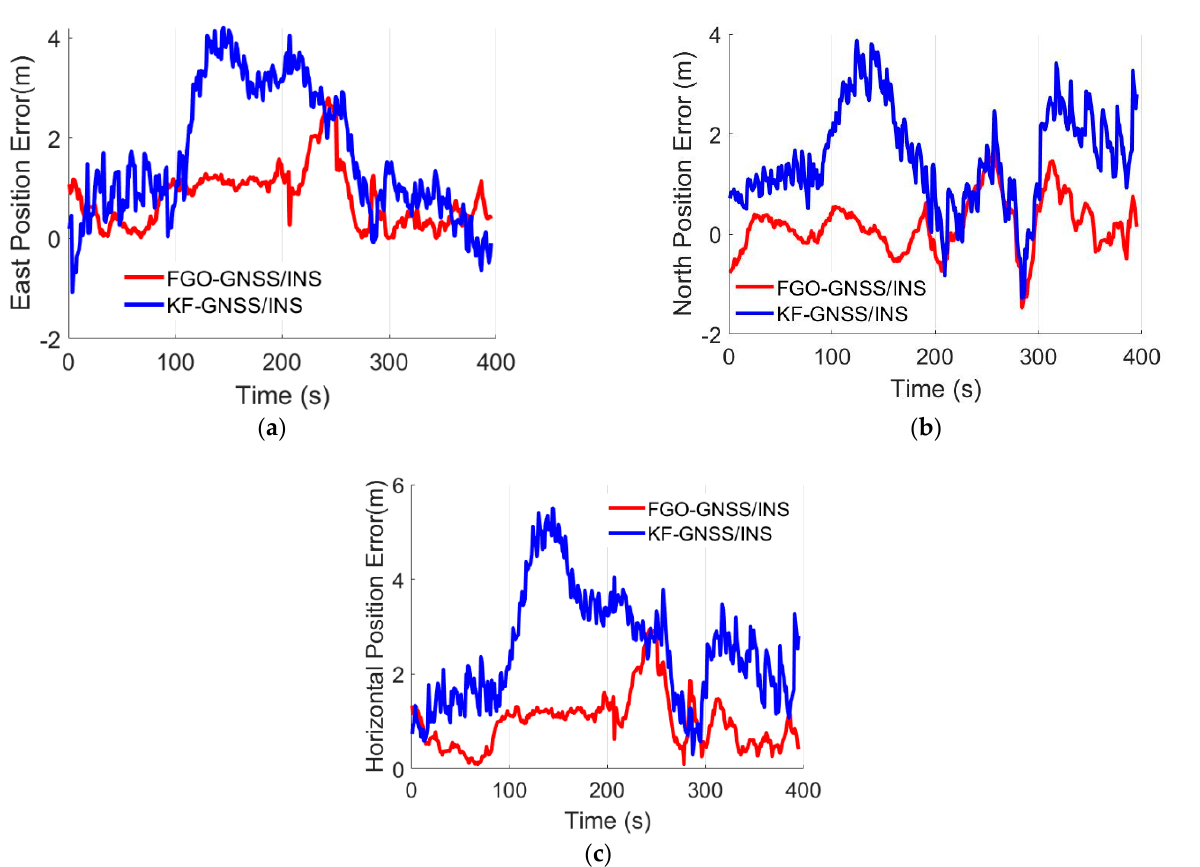
Figure 5. Position errors comparisons. ( a ) East-direction position error. ( b ) North-direction position error. ( c ) Horizontal position errors. Table 2. Latitude position errors analysis and companions.